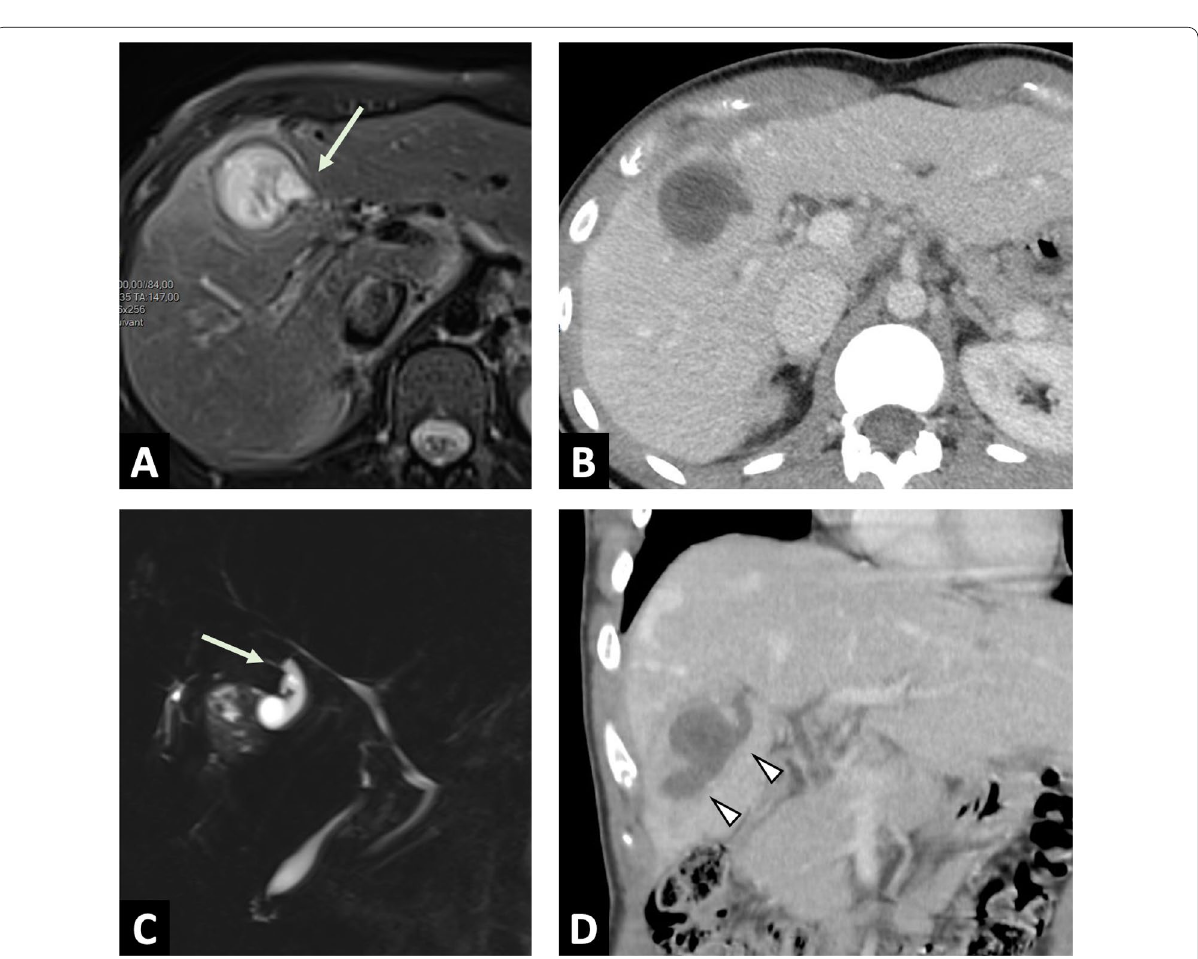
Fig. 17 Cystic echinococcosis lesion CE3b of the right liver lobe in a 44‑year‑old man. A T2‑weighted MR image in the axial plane: loss of continuity of the cyst wall and visualization of daughter cyst into the biliary duct (arrow). B Corresponding images on CT obtained during the portal phase of enhancement. C MRCP in the coronal plane: direct communication between the cyst and the biliary duct (arrow). D Corresponding images on CT obtained during the portal phase of enhancement: direct communication between the cyst and the biliary duct